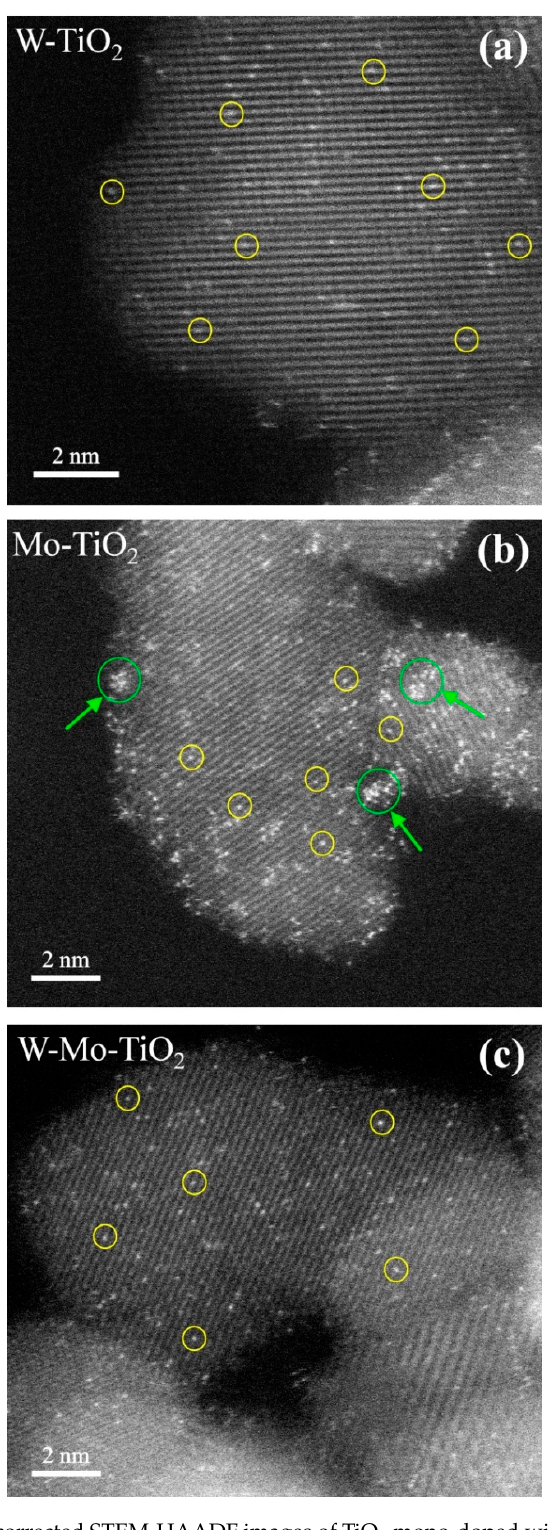
Figure 11. Aberration-corrected STEM-HAADF images of TiO 2 mono-doped with ( a ) W or ( b ) Mo, and ( c ) co-doped with both cations.